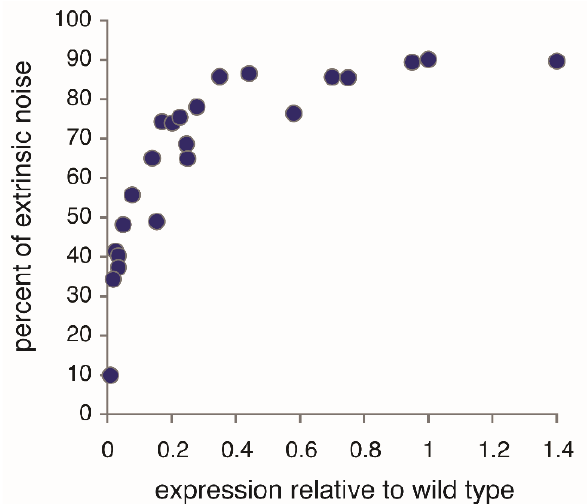
Figure 4. Extrinsic protein noise of PHO5 promoter-driven gene expression as percentage of total noise at different levels of PHO5 expression. Under fully activating conditions (relative expression of 1), extrinsic noise is the dominant noise component. Noise components were determined by the conjugate reporter approach (see main text) with CFP and YFP (derivatives of the green fluorescence protein or “ GFP ” ) expressed under control of the PHO5 promoter [7,37]. (These data have not been previously published.) PHO5 expression was analyzed in pho80 Δ cells, which express PHO5 constitutively, and manipulated by mutating the activation domain of PHO 4, the transcriptional activator of PHO5 [38], or by PHO5 mutation in the binding sequences of PHO 4 [7]. Protein expression was normalized by cell size, a significant contributor to extrinsic variation. Without this normalization, the extrinsic noise was close to 97% of the total noise for the wild type, consistent with earlier measurements